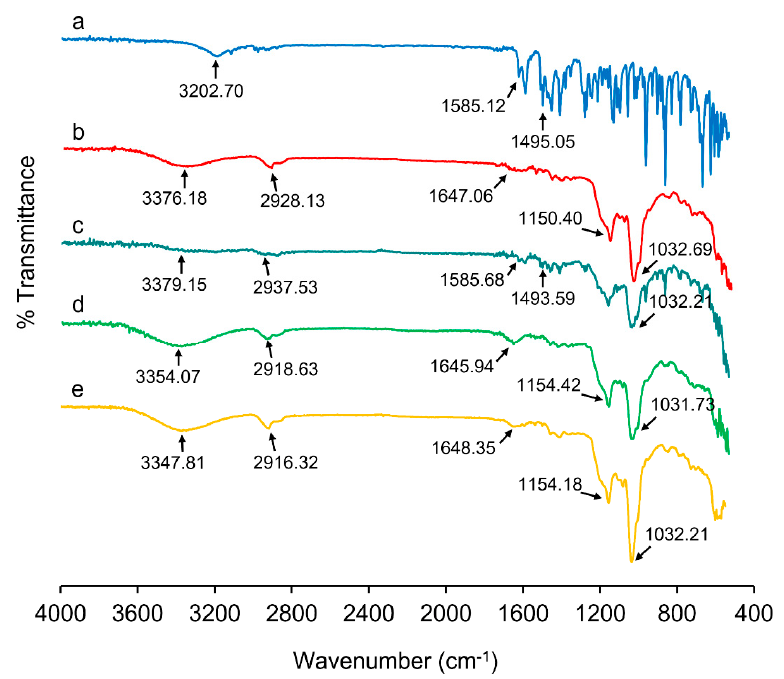
Figure 3. FT-IR spectra of ( a ) VCZ, ( b ) SBE β CD, ( c ) PM VCZ/SBE β CD, ( d ) FD VCZ/SBE β CD and ( e ) FD VCZ/SBE β CD/PVA. ( e ) FD VCZ/SBE β